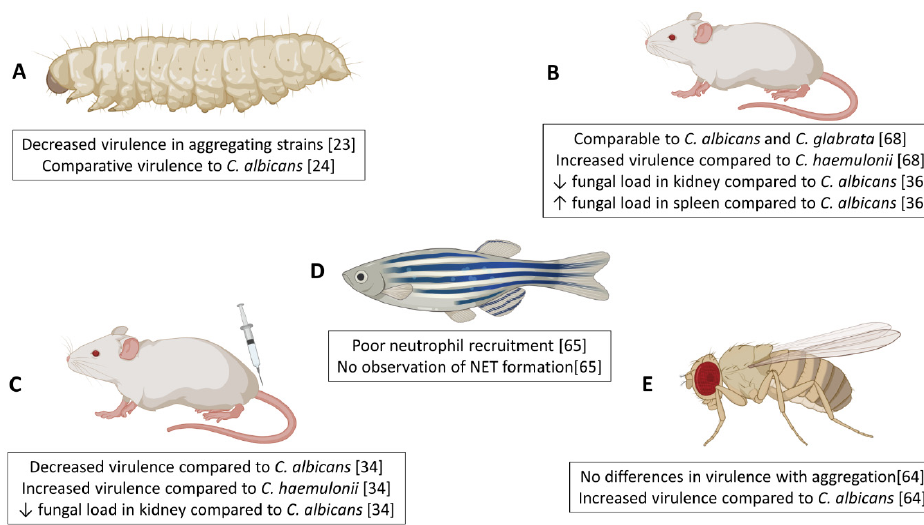
Figure 1. Summary of in vivo pathogenicity studies of Candida auris. The virulence of C. auris in comparison to various other Candida